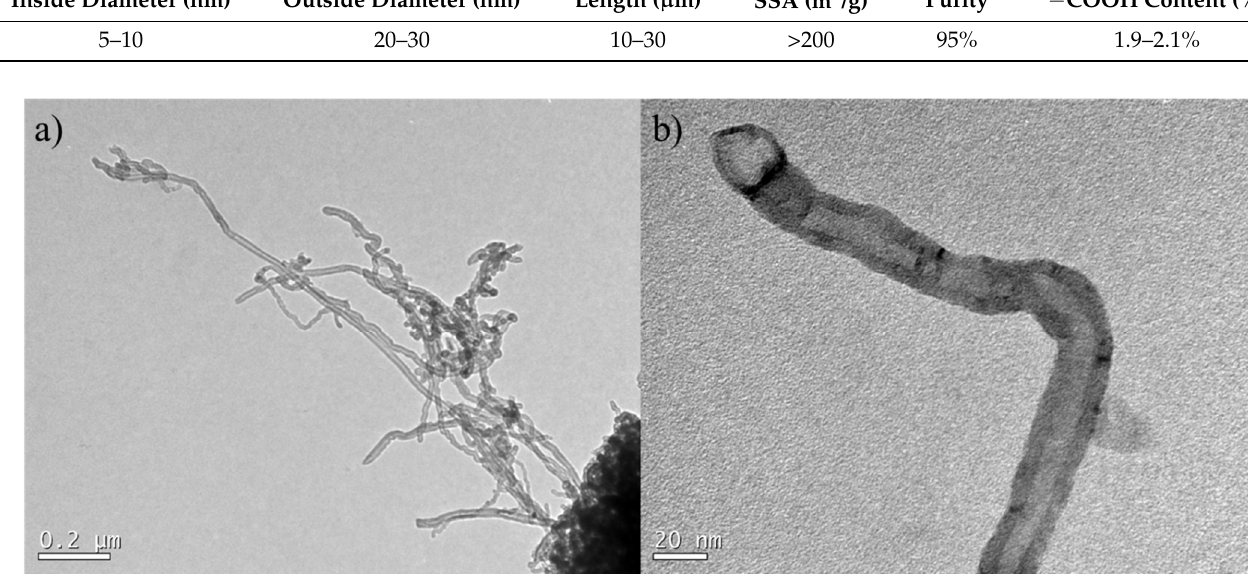
Figure 1. TEM images of the CNT used ( a ) 0.2 µm range; ( b ) 20 nm range.